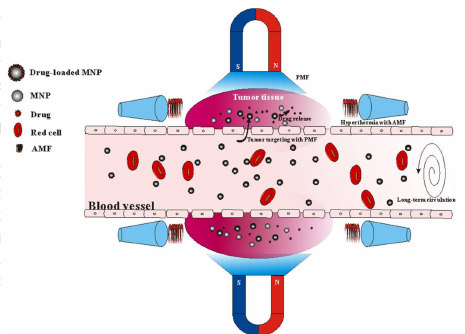
Figure 2. Schematic diagrams of a drug-loaded magnetic nanoparticle (MNP) with tumor targeting, hyperthermia, and long-term circulation.